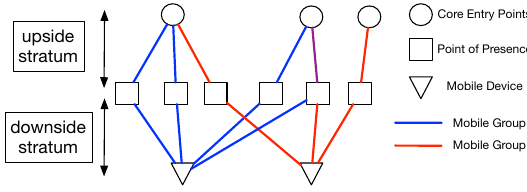
Fig. 2. The representation of mobile group